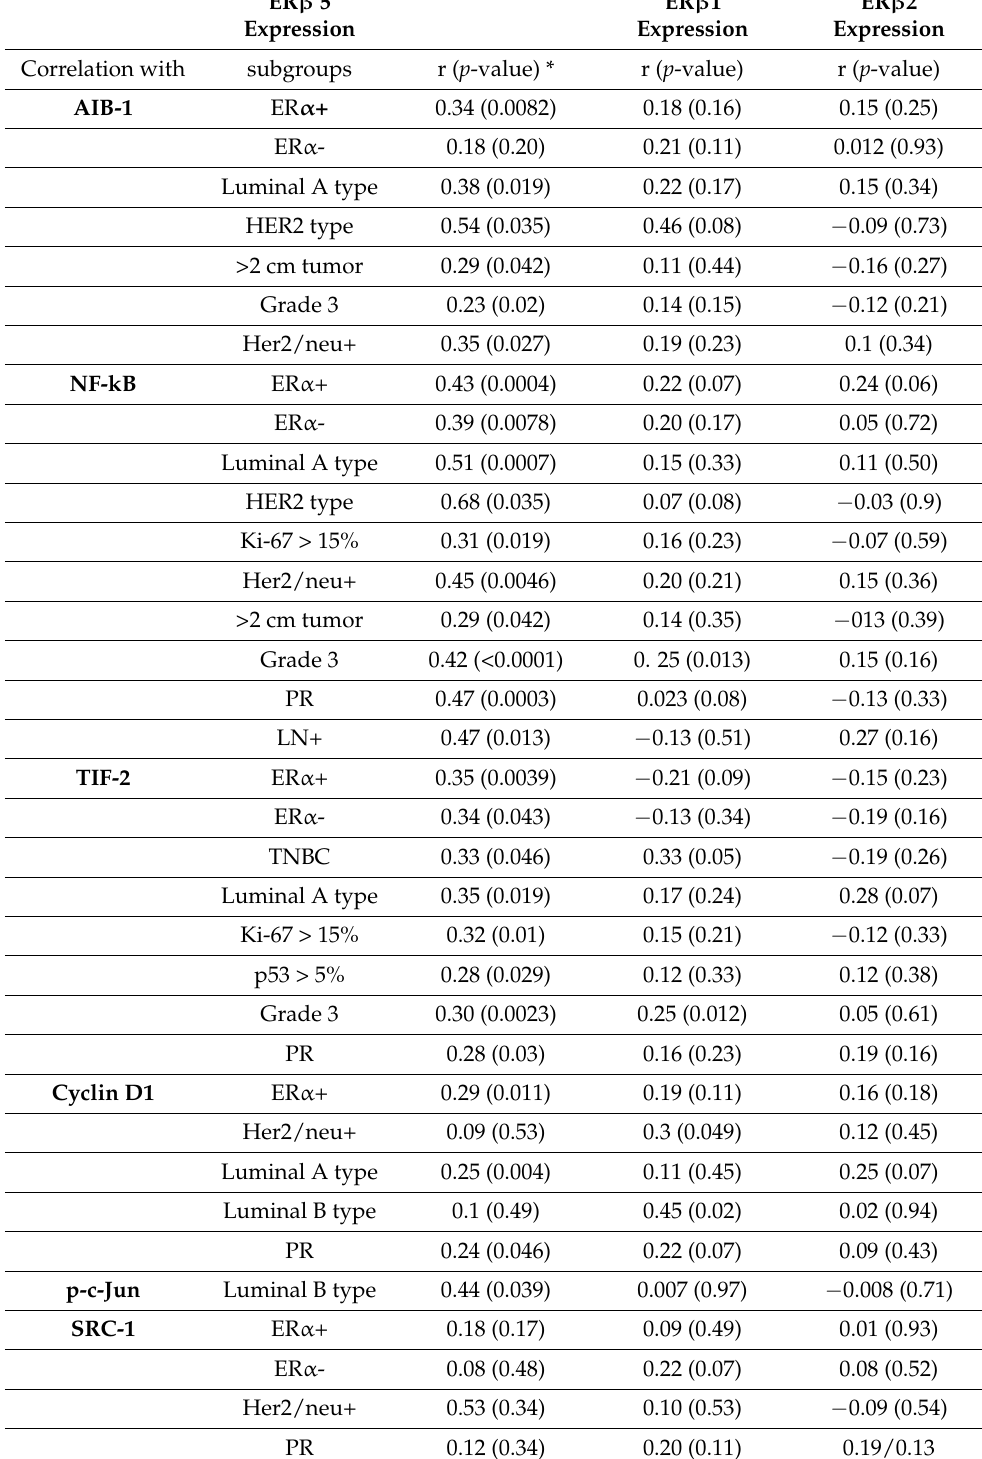
Table 5. Spearman rank correlation of ER β isoforms and coactivators in subtypes and